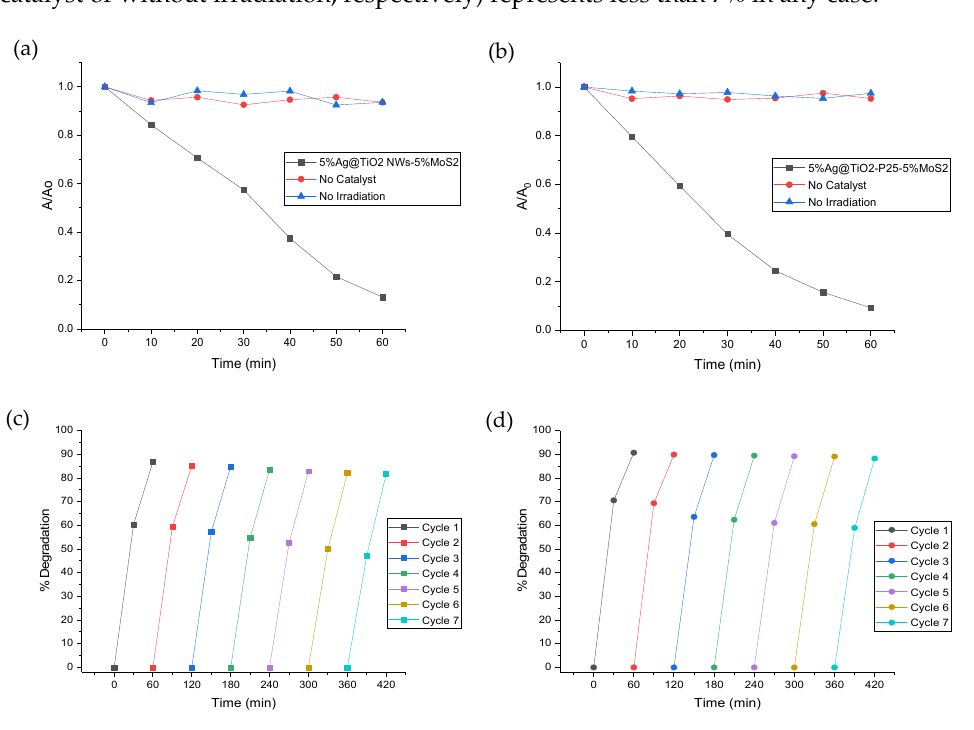
Table 4. Degradation and difference percentages of the 5%Ag@TiO 2 NWs-5%MoS 2 and 5%Ag@TiO 2 - P25-5%MoS 2 catalysts after seven cycles. Catalyst.